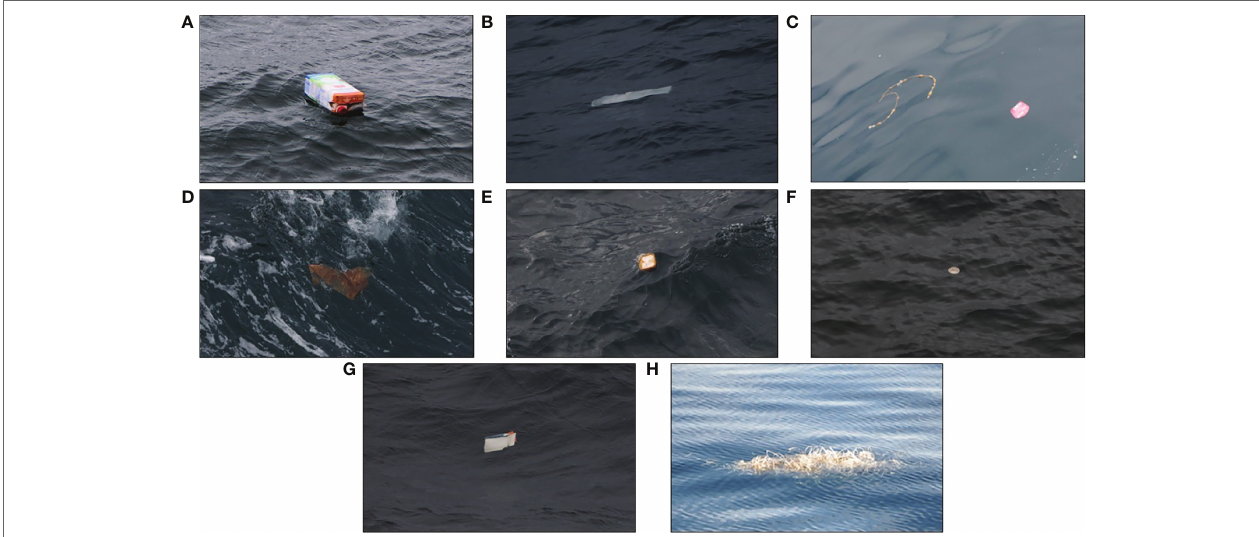
FIGURE 4 | Photographs of floating plastic items observed during RV Polarstern cruise PS99.1 (A) , PS99.2 (B–G) and SV Antigua (H) . (A) Tetra Pak (credit: Christoph Le Gall). (B) White plastic sheet. (C) Red-coloured hard plastic item and fouled rope. (D) Heavily colonised plastic sheet. (E) Plastic lid. (F) Single-use container (G) Piece of cardboard packaging. (H) A bundle of tangled plastic straps (credit: Birgit Lutz). The original images can be found in the Supplementary Material